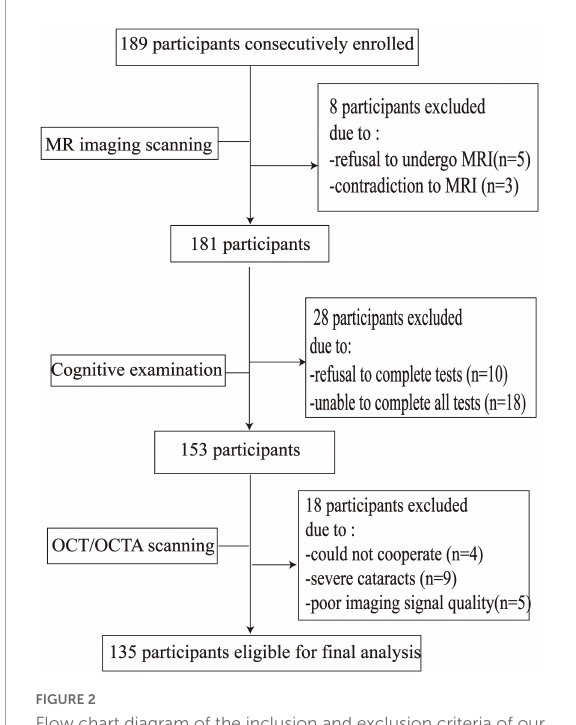
FIGURE2 Flow chart diagram of the inclusion and exclusion criteria of our participants.